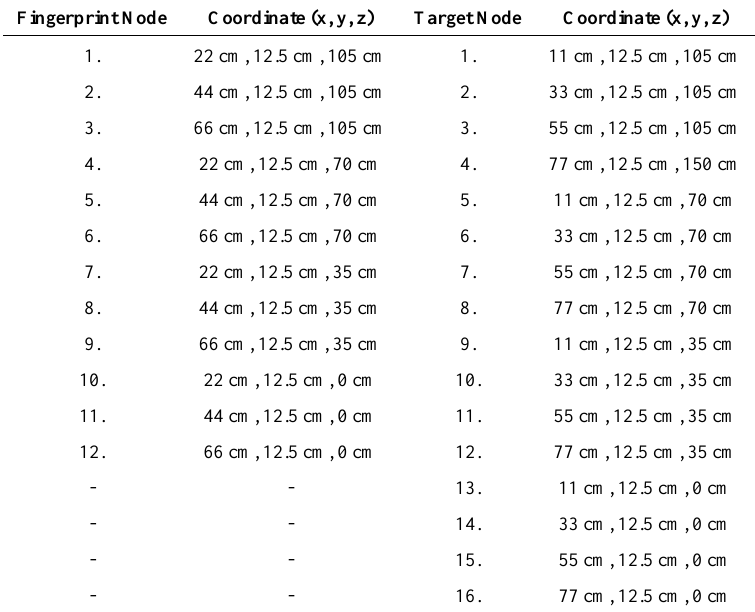
Table 3. 3D fingerprint and target